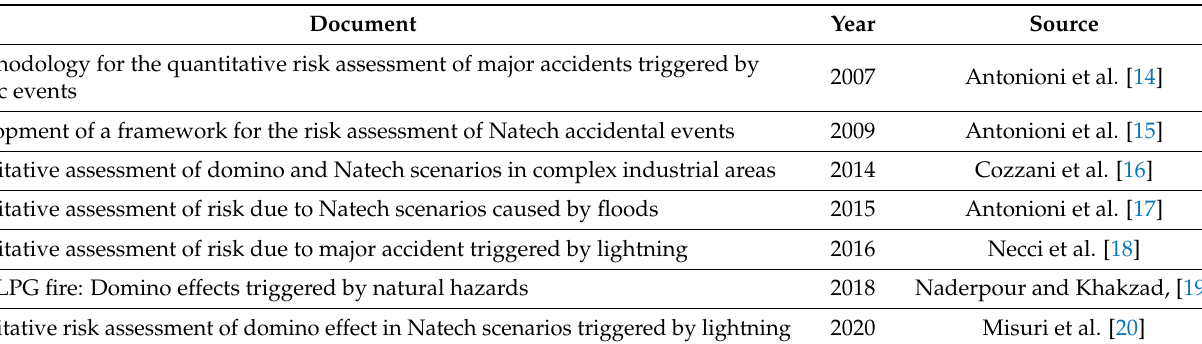
Table 1. Available Natech